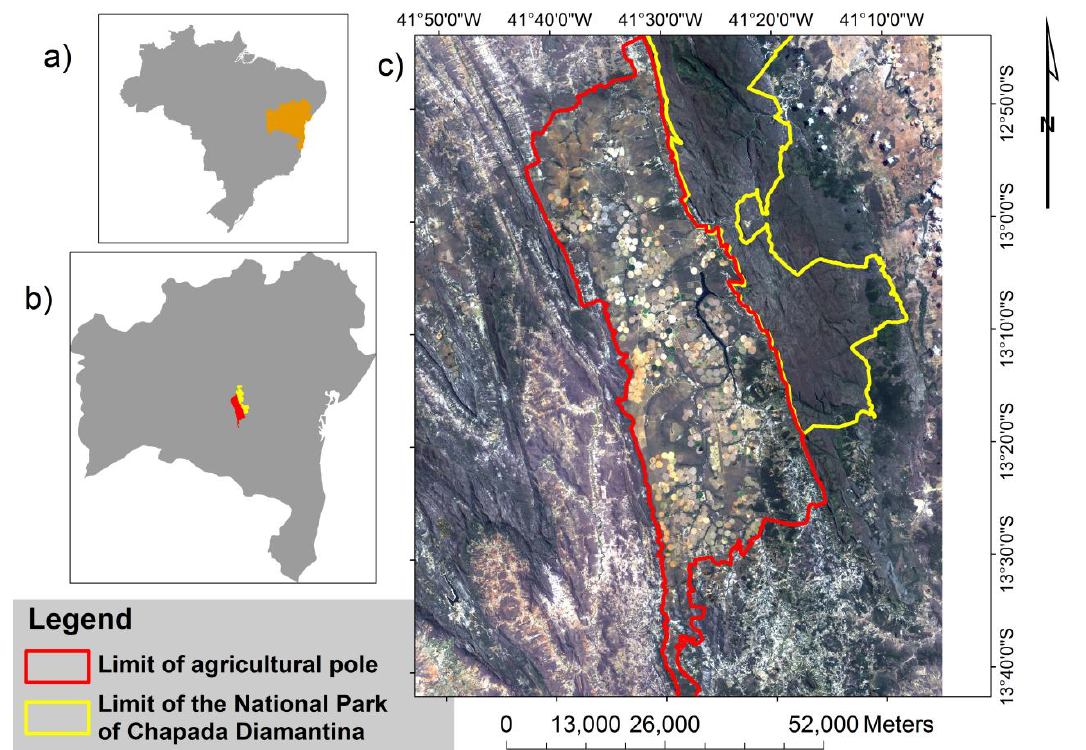
F IGURE 1. Location of the studied apple orchard in the region of Chapada Diamantina. Bahia State is located in the northeast of Brazil (a), and Chapada Diamantina is in the central part of Bahia State (b). Right panel, high-resolution (pixels of 5 m per side) satellite image (SPOT) obtained in September of 2008 (c); the studied apple orchard is located in the pole of irrigated agriculture between the municipalities of Ibicoara and Mucugê (190,000 ha or approximately 470,000 acres) and is bordered by Chapada Diamantina National Park.